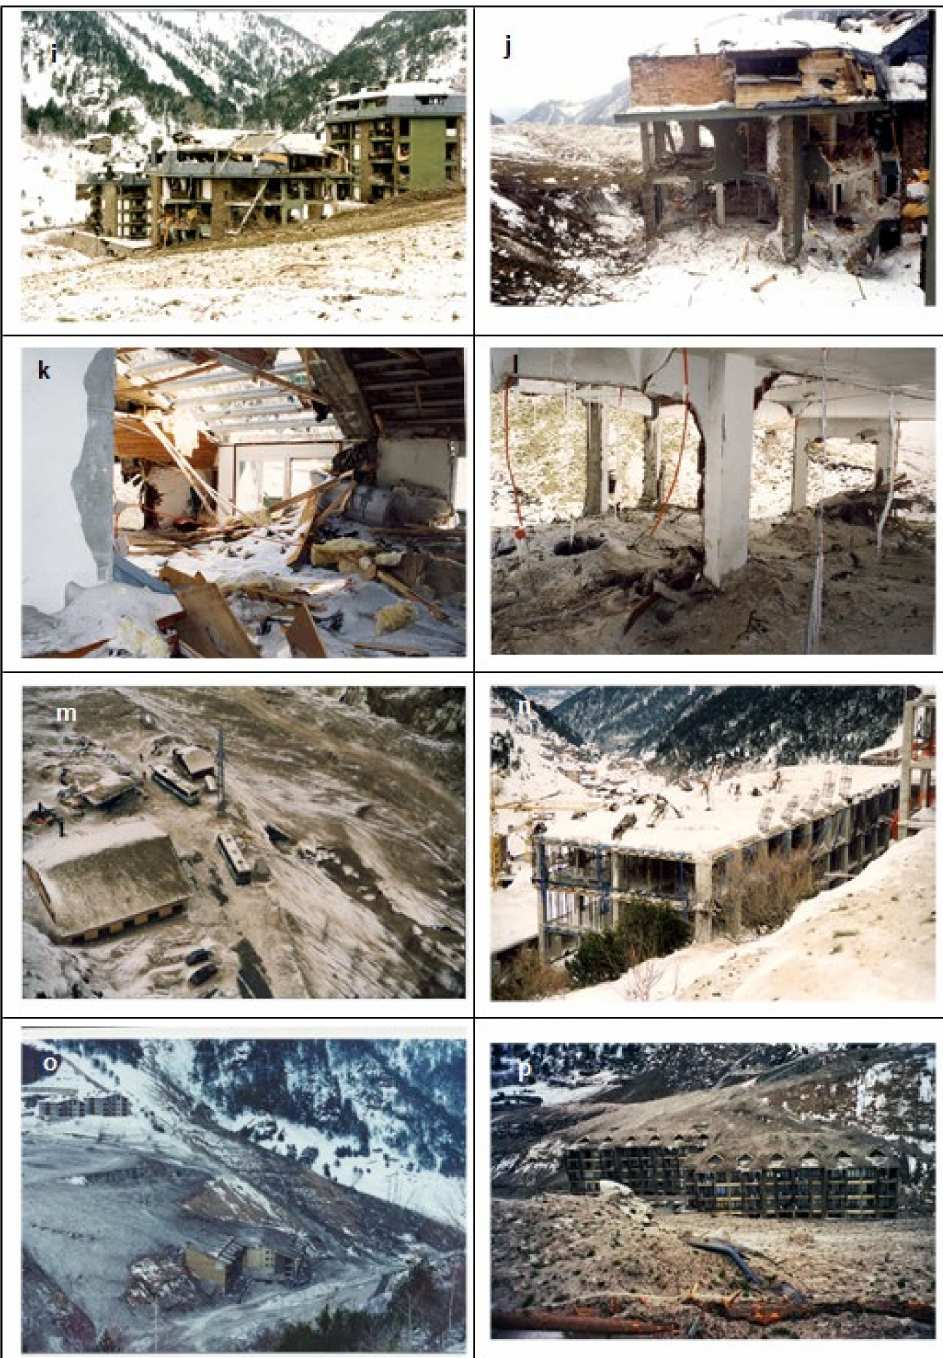
Figure 10. Pictures of damage in the run-out zone: ( a ) Peu de Pistes (PdP) building with the roof lifted and destroyed; ( b ) PdP building with the roof lifted and destroyed displaced backwards; ( c ) PdP and Crest Hotel with plastered snow filling the ground floor; ( d ) PdP apartment with window glass broken; ( e ) PdP apartment filled with dirt snow; ( f ) car smashed in front of PdP; ( g ) Crest Hotel roof skylights burst; ( h ) van wrapped around a chairlift pylon; ( i ) Prat Sobirans (PS) buildings destroyed; ( j ) PS D block with structural damage; ( k ) PS D block, top apartment, roof and partitions destroyed; ( l ) PS D block, ground floor; ( m ) aerial view of the ski lift area, the bottom right-hand corner points to the Astra complex; ( n ) Astra complex building in construction, protruding parts of the reinforced concrete’s iron rods bent by the aerosol blow; ( o ) run-out slope, Velvet and Amadeus blocks; ( p ) Amadeus